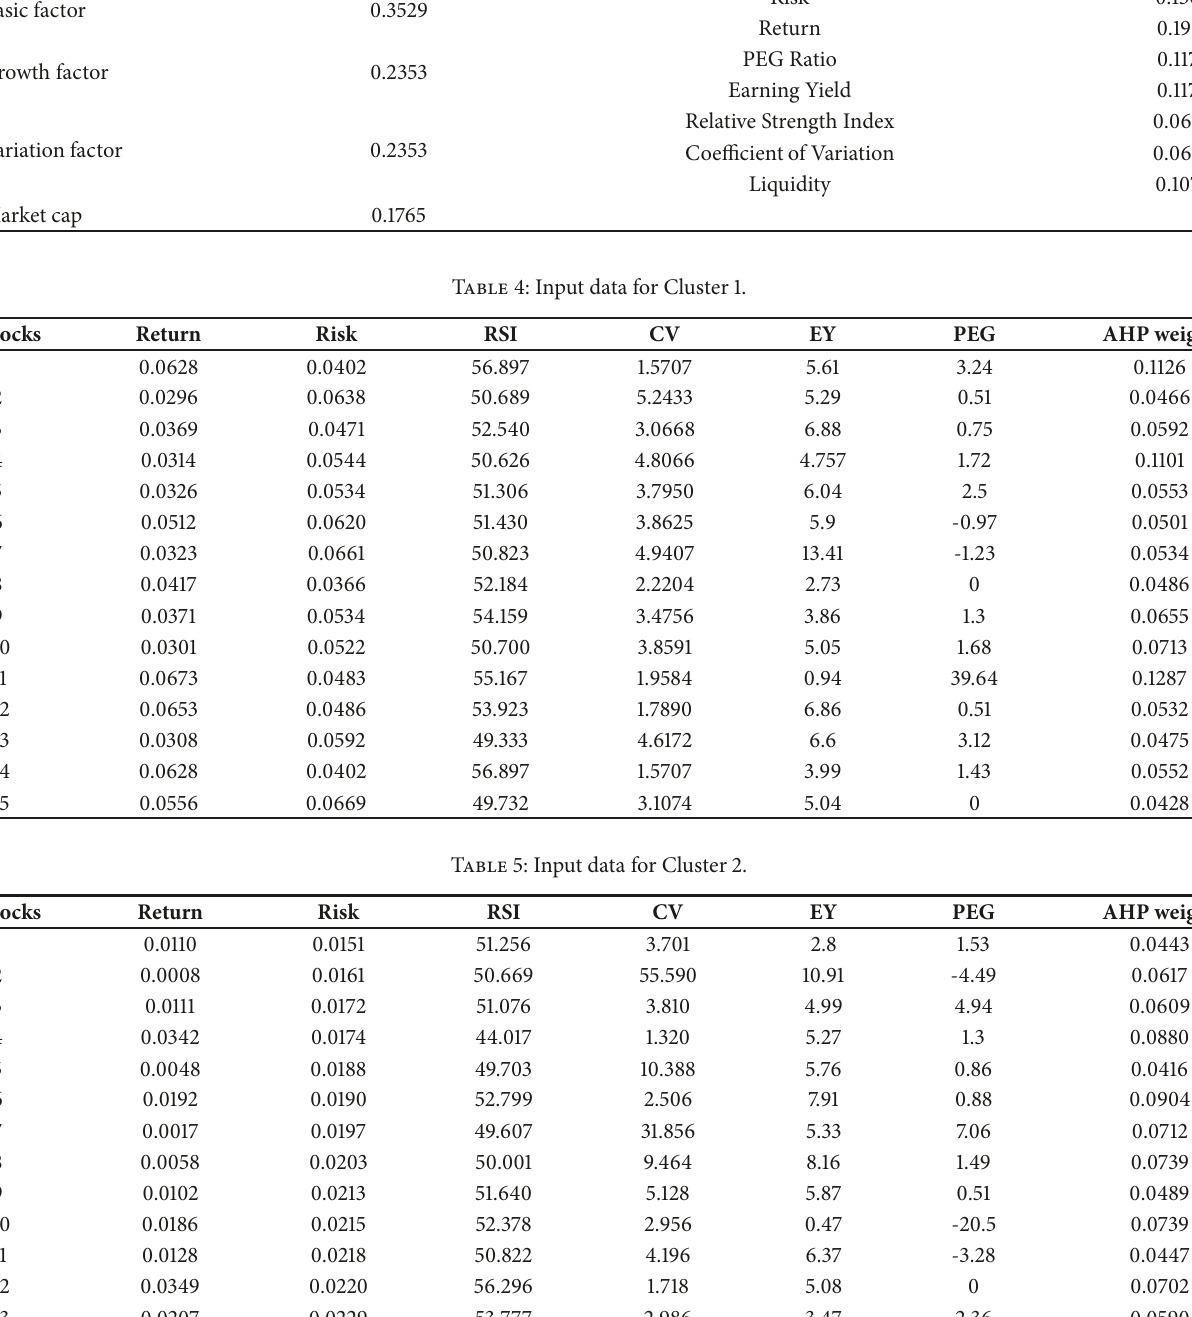
cluster are given by Table